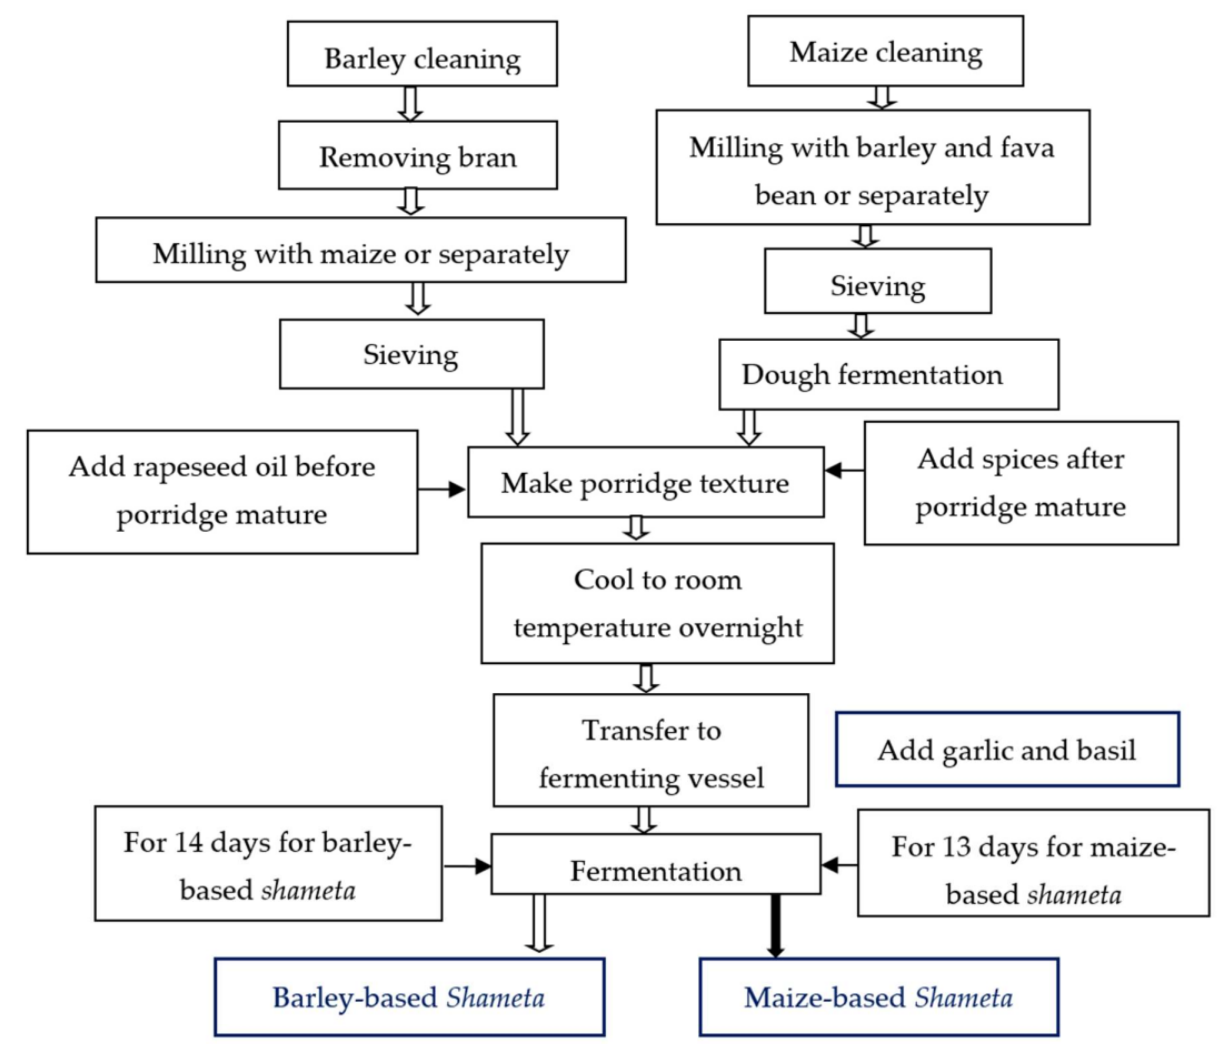
Figure 2. Flow diagram of traditional barley and maize-based Shameta preparation. Maize-based Shameta fermentation: As its name indicates, the major ingredient used for maize-based Shameta preparation was maize ( Zea mays ) (9.72 kg). Barley ( Hordeum vulgare ) (0.6 kg) and faba beans ( Vicia faba L.) (0.6 kg) were added as minor or